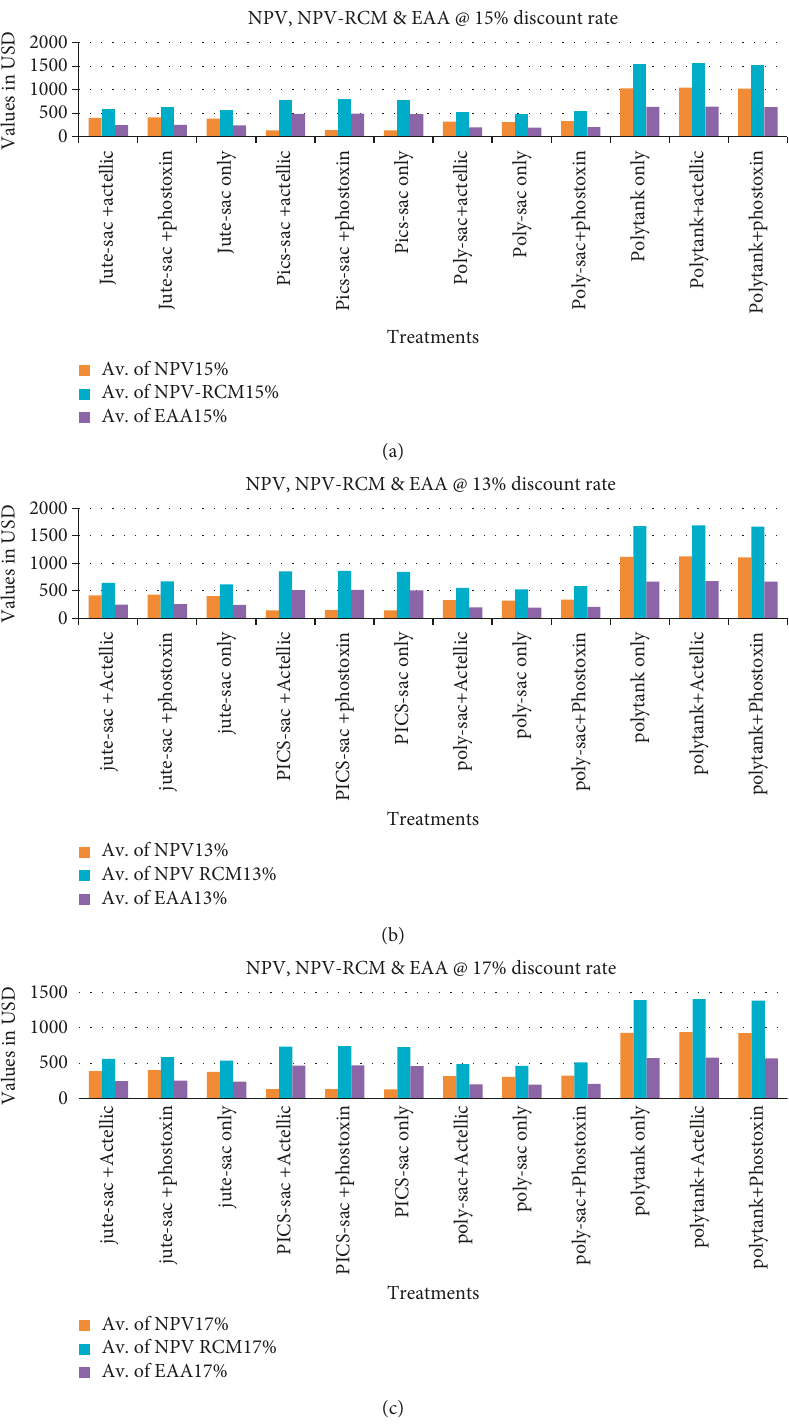
Figure 3: NPV, NPV-RCM, and EAA at a discount rate of 15%, 13%, and